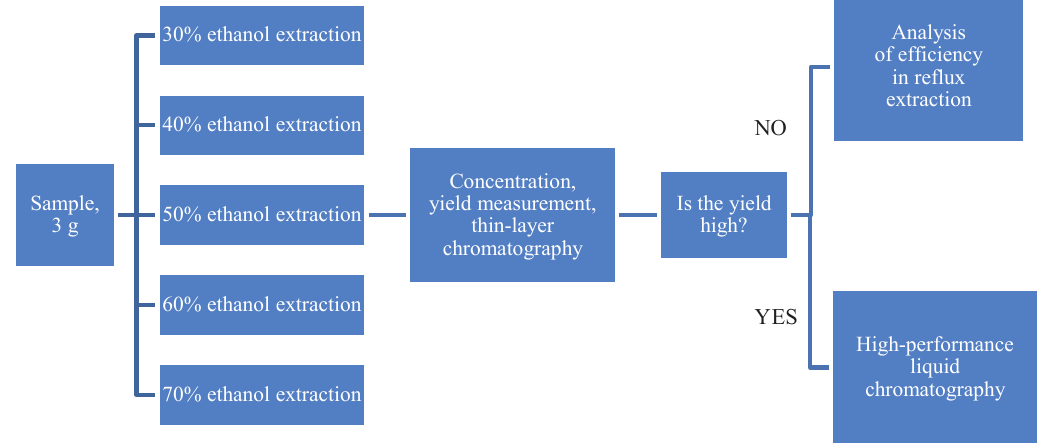
Figure 1 Solvents efficiency in extracting biologically active substances from ginseng